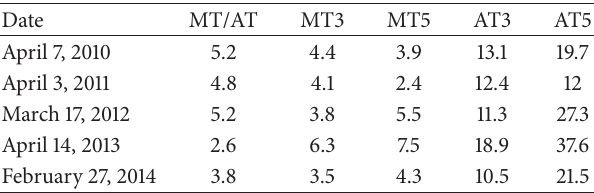
Table 3: Temperature statistics and specific dates for the first day of observation of T. cristatus from 2010 to 2014. Precipitation levels are not included in the table as they were all 0–0.1 mm. Detailed variable descriptions are provided in Table 2. First observations of L. vulgaris coincided with T. cristatus for all years, except for 2011 and 2014, where the first observations were registered one and eight days later, respectively.